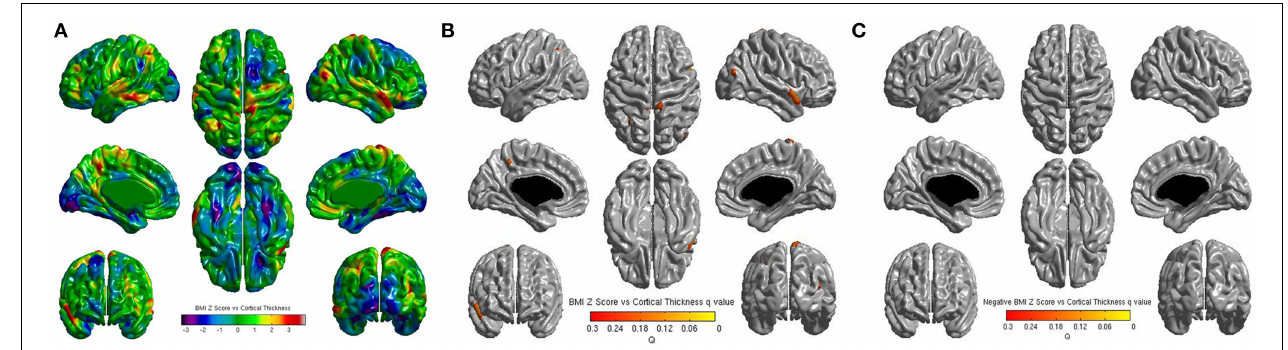
FIGURE 4 | (A) Unthresholded correlations between BMI Z-Score for age and cortical thickness across the entire brain, shown here for comparison. Typically T -values of around 4 or greater are needed to reach significance. (B) Positive correlations between BMI Z-Score for